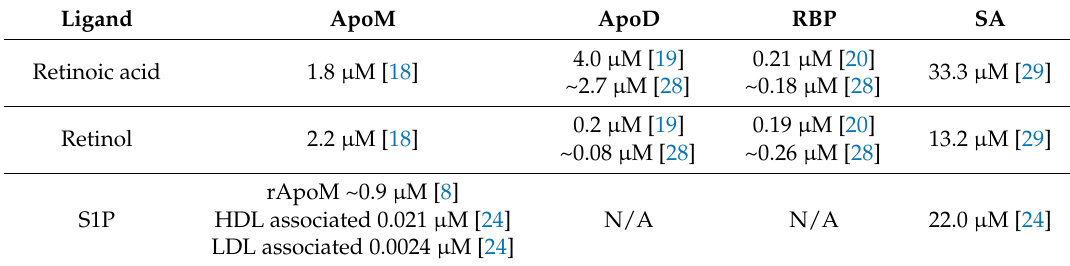
Table 1. Average K D values of S1P binding to various acceptor proteins. RApoM: recombinant human Apolipoprotein M; ApoD: human Apolipoprotein D; RBP: human retinol binding protein; SA: